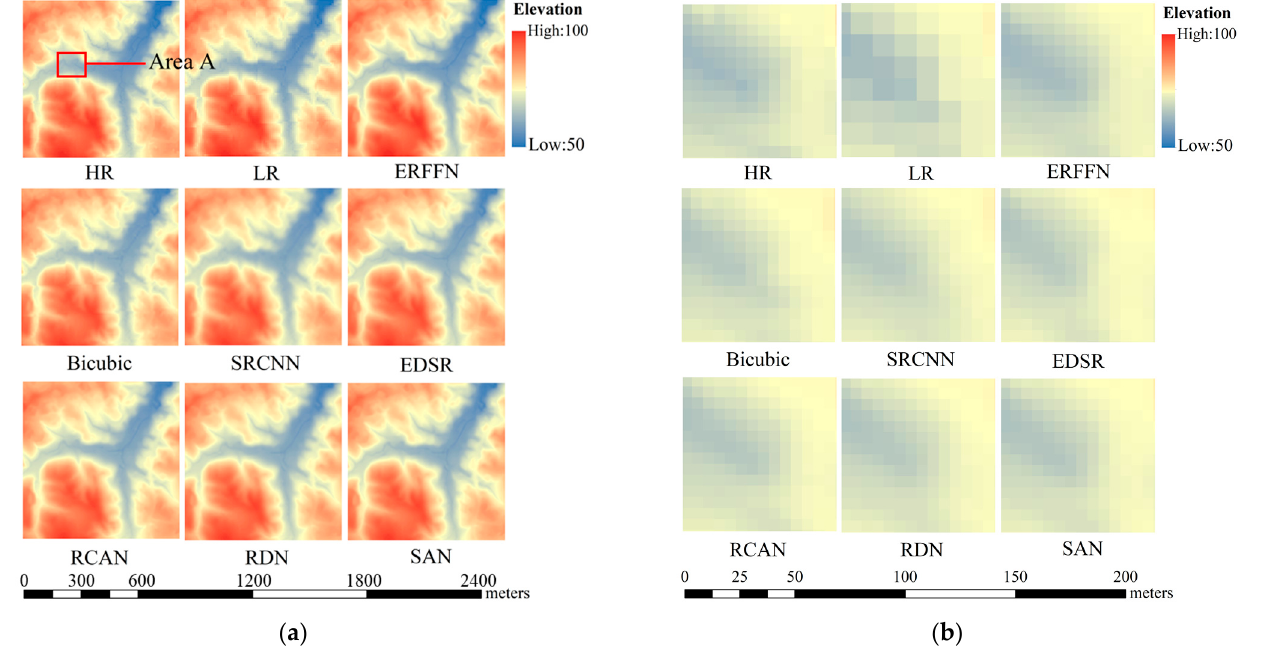
Figure 9. ( a ) The reconstruction of 5 m DEMs using different methods. ( b ) Zoomed in area A of ( a ).